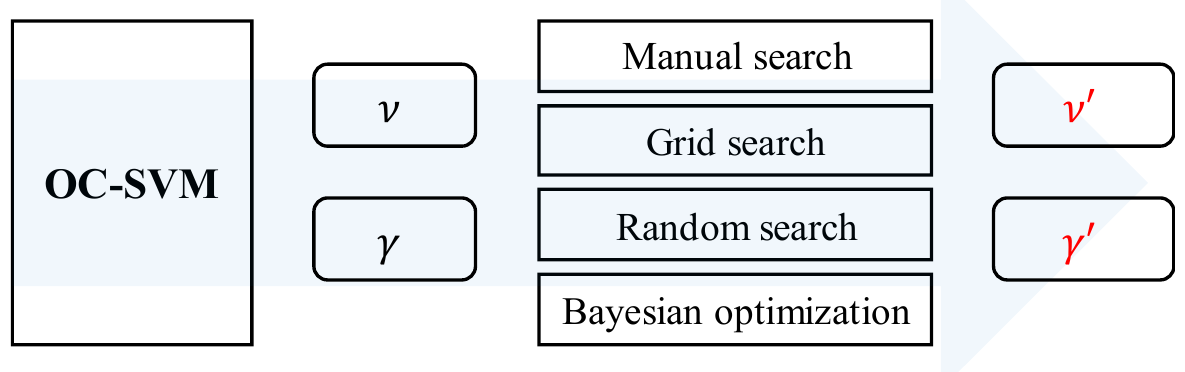
Figure 3. The whole process for hyperparameter tuning.